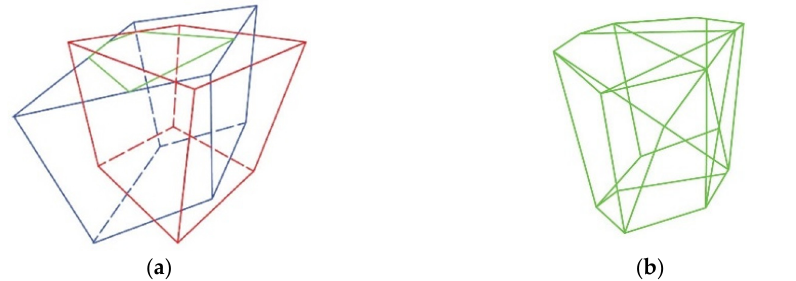
Figure 1. Computation of ( a ) intersection points is depicted in green and ( b ) intersection volume is indicated in green.